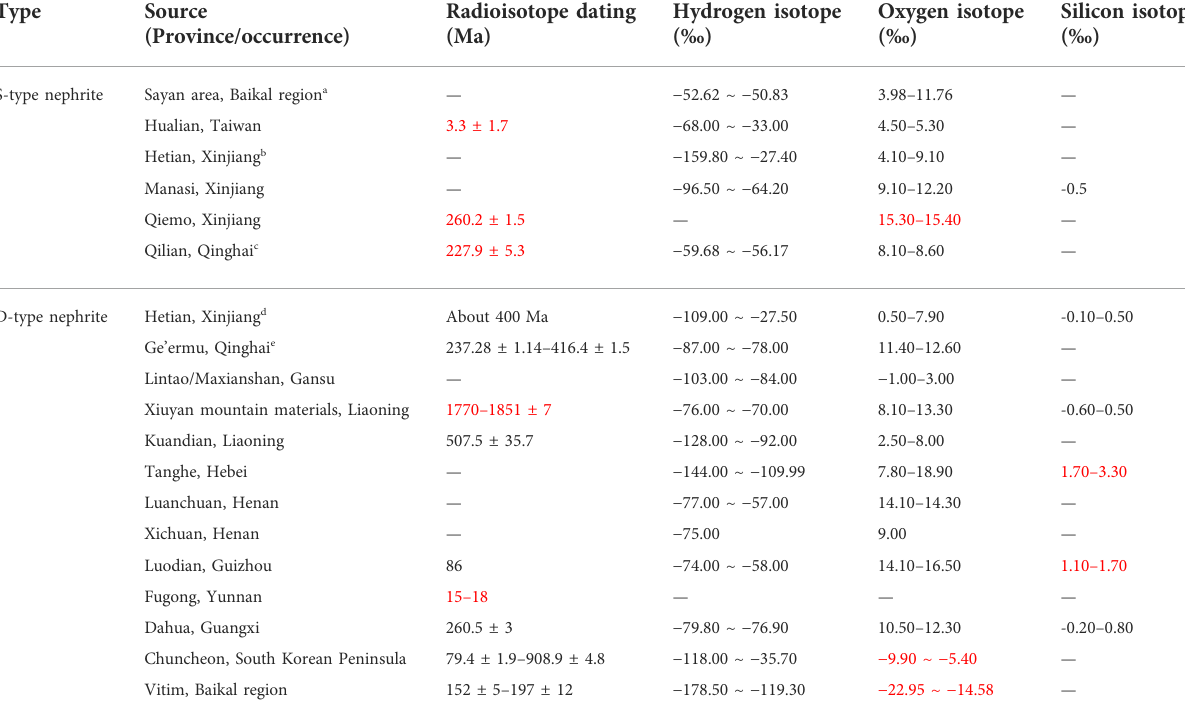
TABLE 5 Isotopic values of nephrite deposits in Northeast Aisa, Yellow River Basin and South